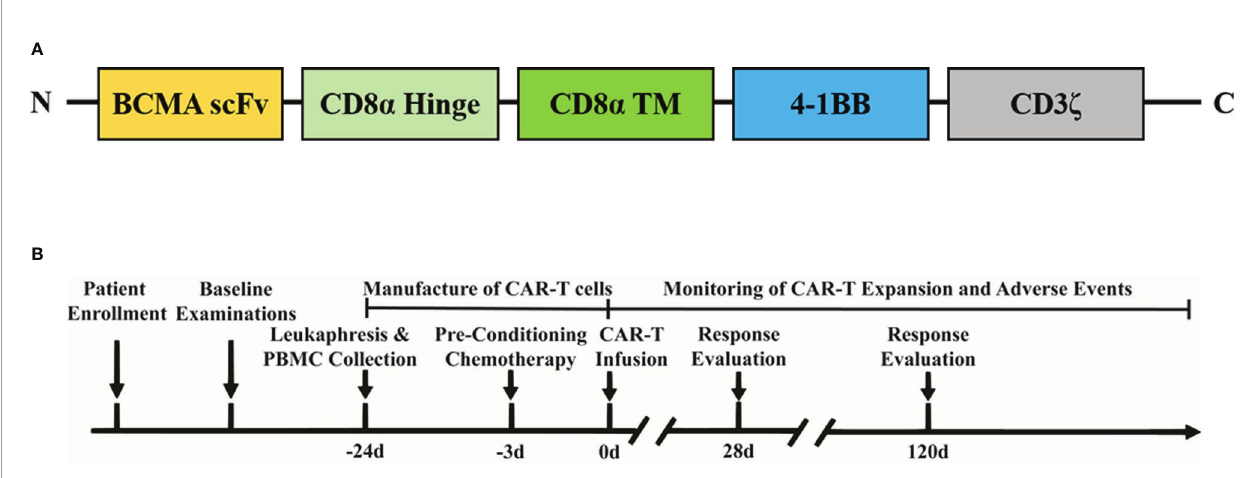
FIGURE 1 | Schematic illustration of the CAR construct and treatment timeline. (A) Composition of CAR molecule. (B) Clinical study